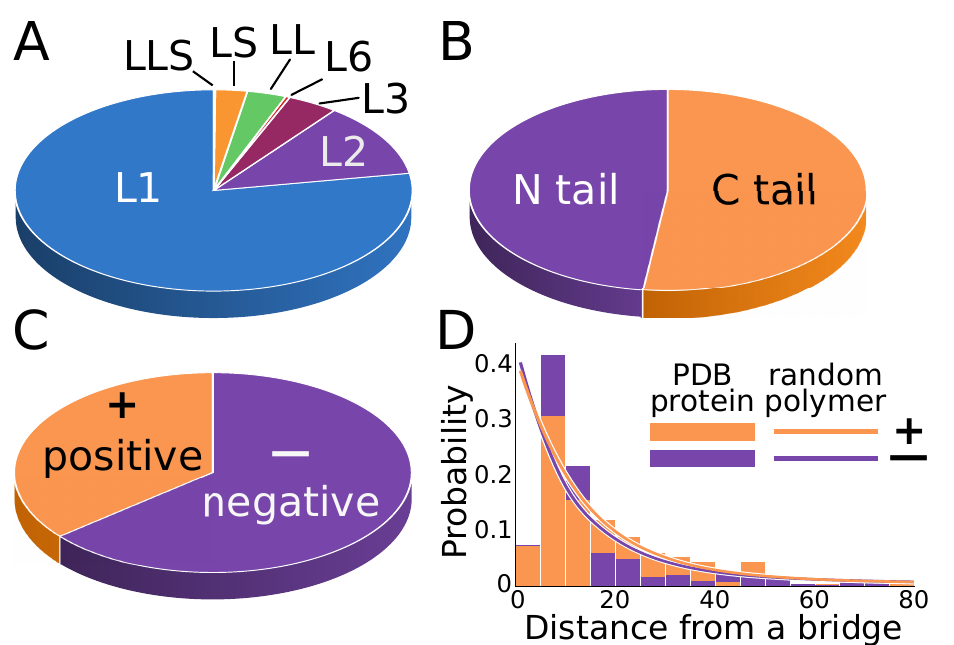
Figure 4. Statistics of loop-type ocurence among the non-redundant set of proteins. The pie charts present ( A ) major types, ( B ) piercing tails, and ( C ) the piercing direction. In ( B , C ), all lassos except the two-sided ( LL ) class are taken into account. ( D ) Histogram of the sequential distance between the bridge and the nearest piercing with distinction of the positive (+) and negative ( − ) piercings. Curves represent the theoretical prediction for a random polymer (based on the fit of the simulated data in